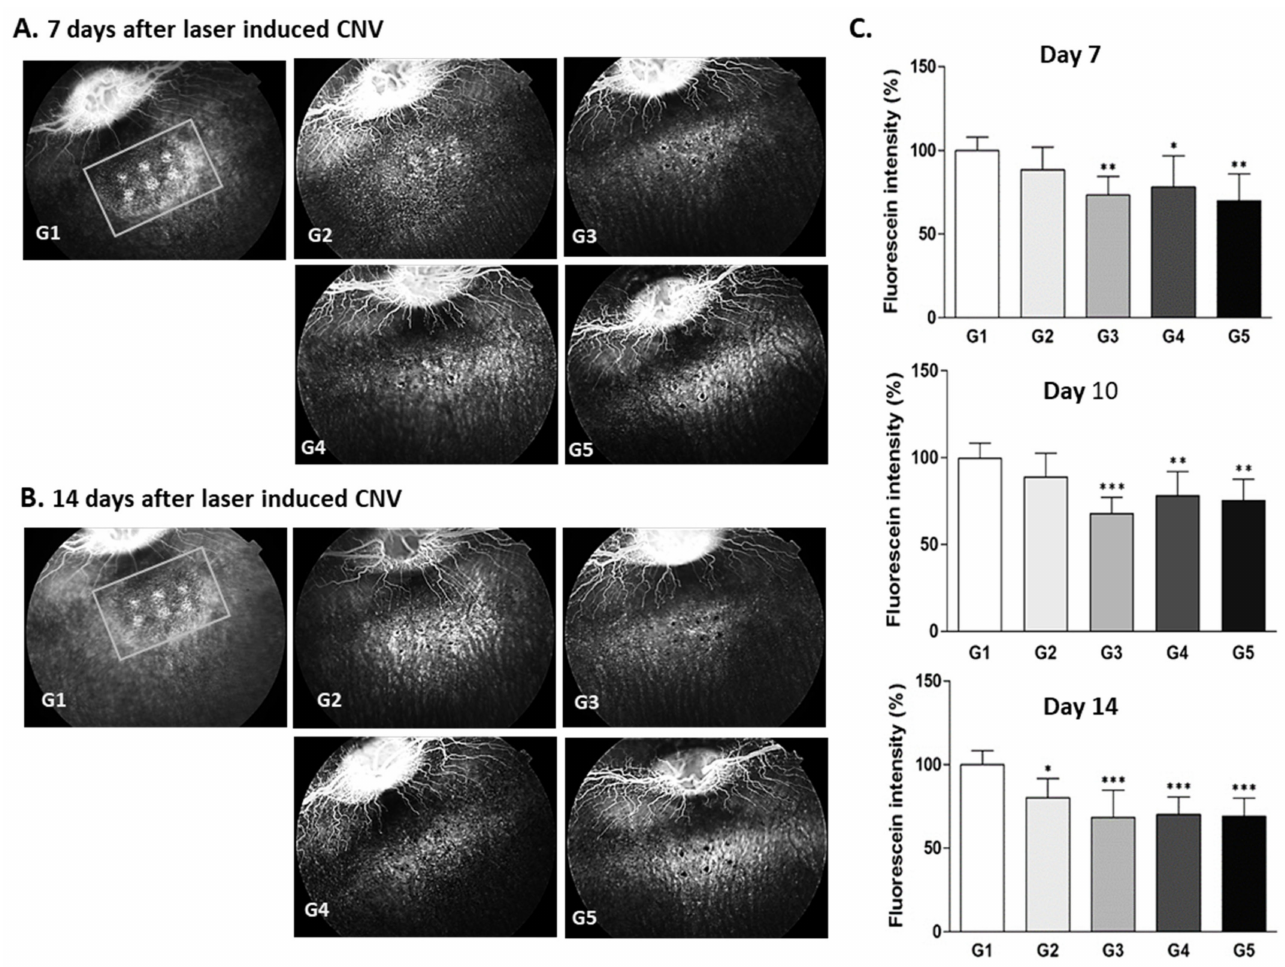
Figure 4. The effects of the intravitreal administration of Ac-RLYE and ranibizumab on inhibition of choroidal neovascu- larization (CNV) in laser-induced CNV rabbit models with treatment of peptide or ranibizumab at the same day as laser irradiation. The intensity of laser irradiation and spot size was empirically set to maintain the retinal fluorescence intensity in the vehicle treatment group at 2 weeks after laser irradiation. ( A , B ): Representative retinal fluorescence fundus image analyzed after injection of fluorescein sodium salt through the ear vein at each day after laser irradiation. ( C ): A quantitative image analysis result for retinal fluorescence intensity using the ImageJ software ( n = 6 rabbits per group). The day of laser irradiation was designated as day 0. Data are expressed as mean ± S.D. G1: Vehicle control, G2: Ac-RLYE 0.2 µ g/50 µ L/eye, G3: Ac-RLYE 2 µ g/50 µ L/eye, G4: Ac-RLYE 20 µ g/50 µ L/eye, G5: Ranibizumab 500 µ g/50 µ L/eye. ***/**/* A